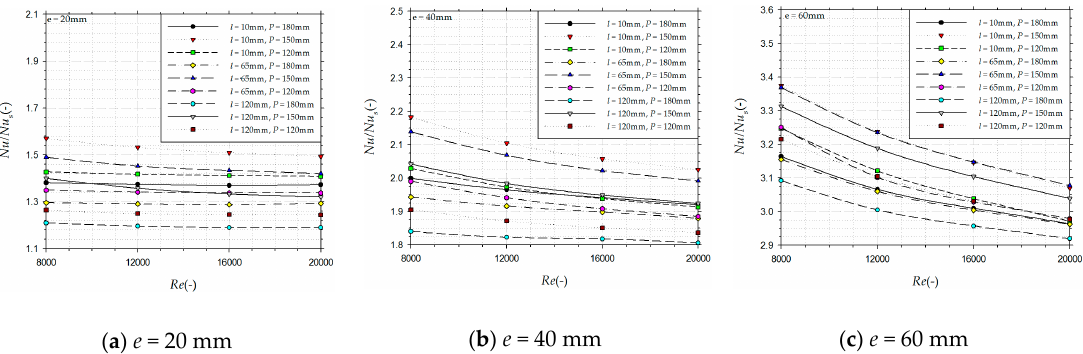
Figure 9. Enhancement in Nusselt number for different value of pitch ( P ), length ( l ), and for a fixed value of height ( e ) with Reynolds number.